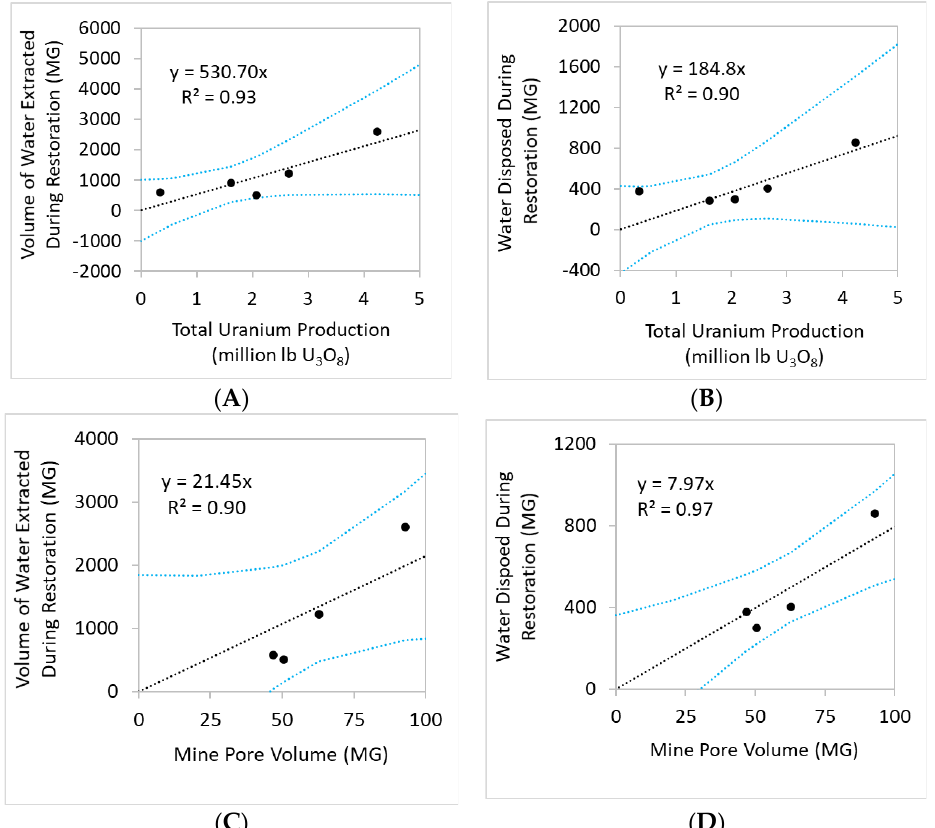
Figure 10. The amount of water ( A ) extracted and ( B ) disposed during groundwater restoration as a function of uranium produced (as lb U 3 O 8 ) for Alta Mesa, Kingsville Dome, Mt. Lucas, Palangana Dome and Rosita (restoration not yet begun on Palangana) and the amount of water ( C ) extracted and ( D ) disposed during groundwater restoration as a function of mine pore volume for Kingsville Dome, Mt. Lucas, Palangana Dome and Rosita (pore volume not reported for Alta Mesa). Compiled data used to construct these graphs as well as associated references are publicly available online [18]. Note: MG = million gallons. Black line is the linear trend line and blue lines are the 95 percent confidence intervals.